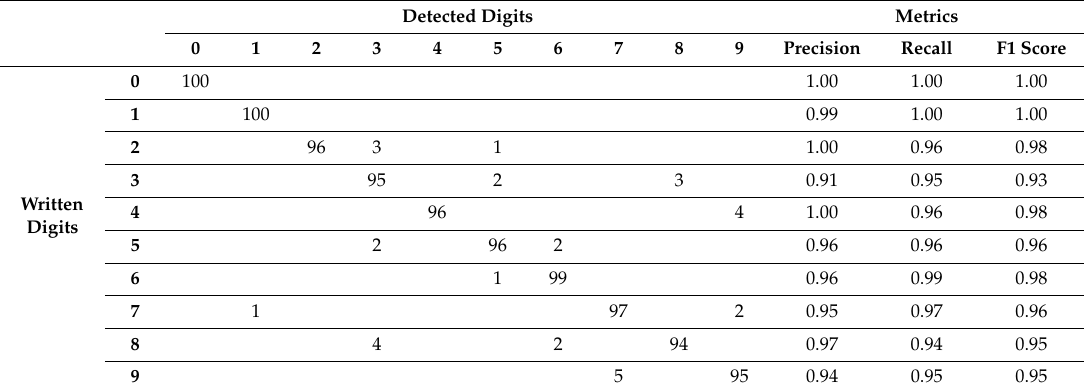
Figure 9. Number of correctly classified inputs for each digit with the confidence intervals for each digit. Table 1. Confusion matrix for real-time recognition testing with metrics (precision, recall, F1 score) for each digit.